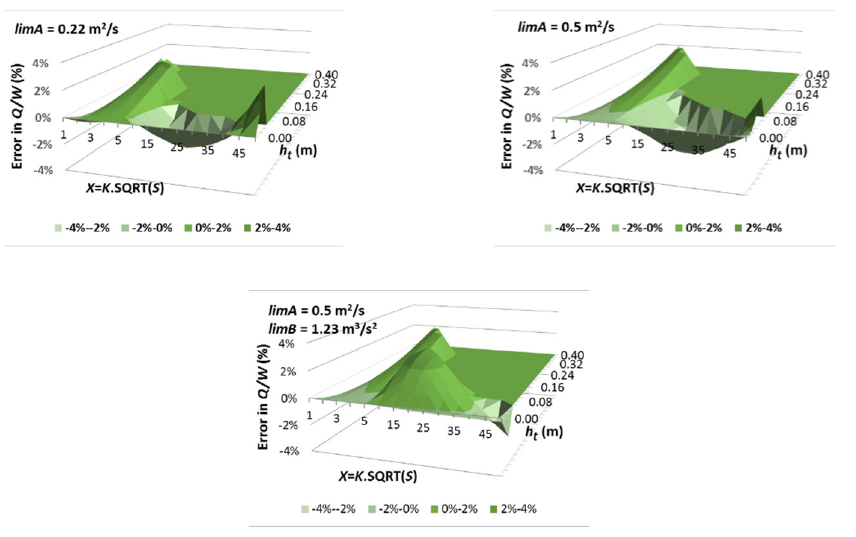
Figure 4. Errors in the estimation of Q / W for limA = 0.22 m 2 /s and limA = 0.5 m 2 /s, and for the combination of limA = 0.5 m 2 /s and limB = 1.23 m 3 s − 2 .